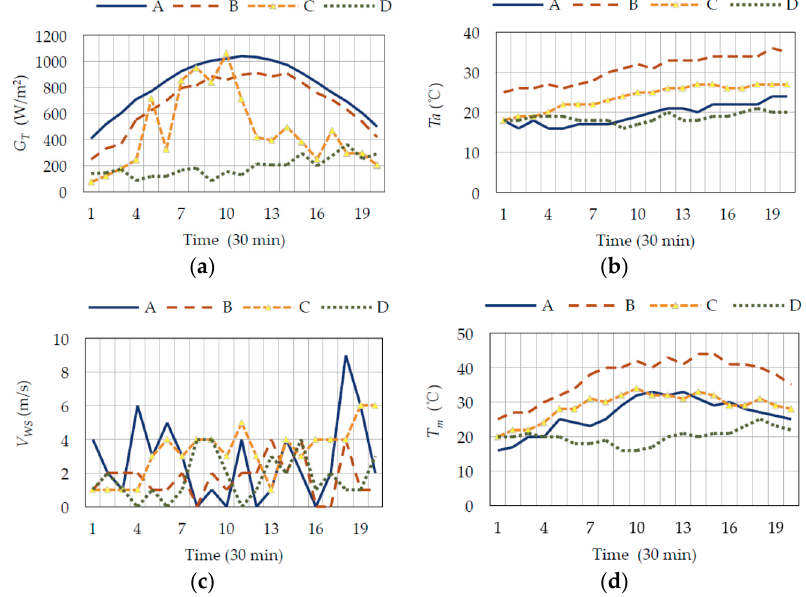
Figure 4 . Actual data of PV module temperature and meteorological impact factors (MIFs) under four general weather classes (GWCs): ( a ) solar irradiance; ( b ) ambient temperature; ( c ) wind speed; and ( d ) PV module temperature.